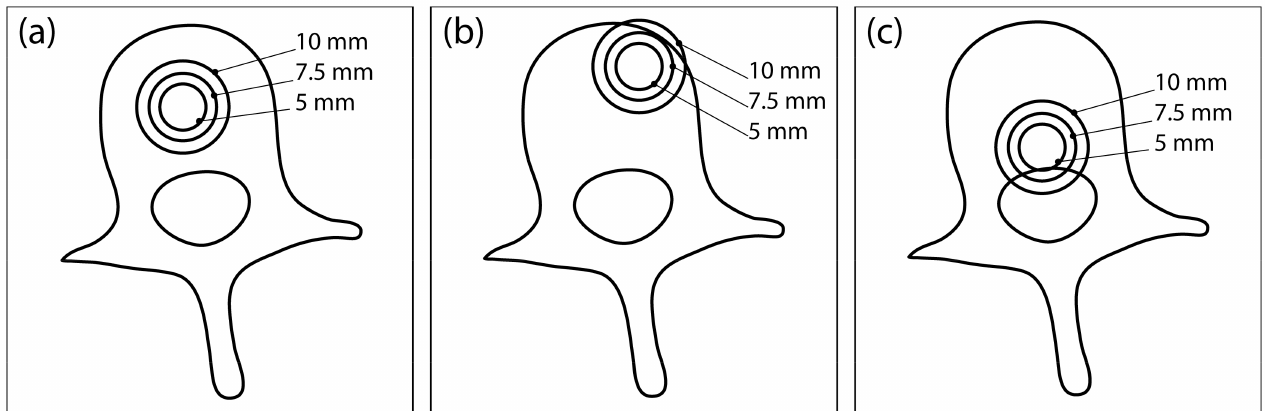
Figure 1. Three different tumor locations within the vertebral body: ( a ) central location, ( b ) anterior- lateral location, and ( c ) posterior-inferior location. At each location, the tumor is modelled with three different radii: 5 mm, 7.5 mm, and 10 mm. This illustration was created from an axial CT section of an L3 vertebra and does not show the actual geometry of the numerical model used for